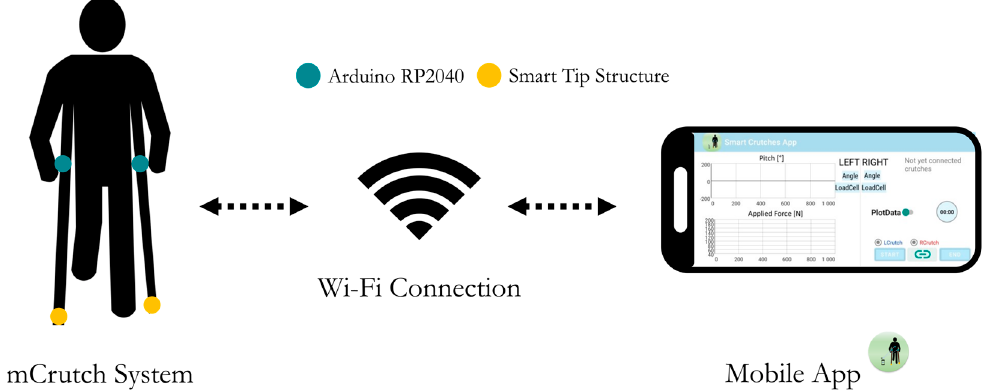
Figure 2. System overview: mCrutches and mobile app.